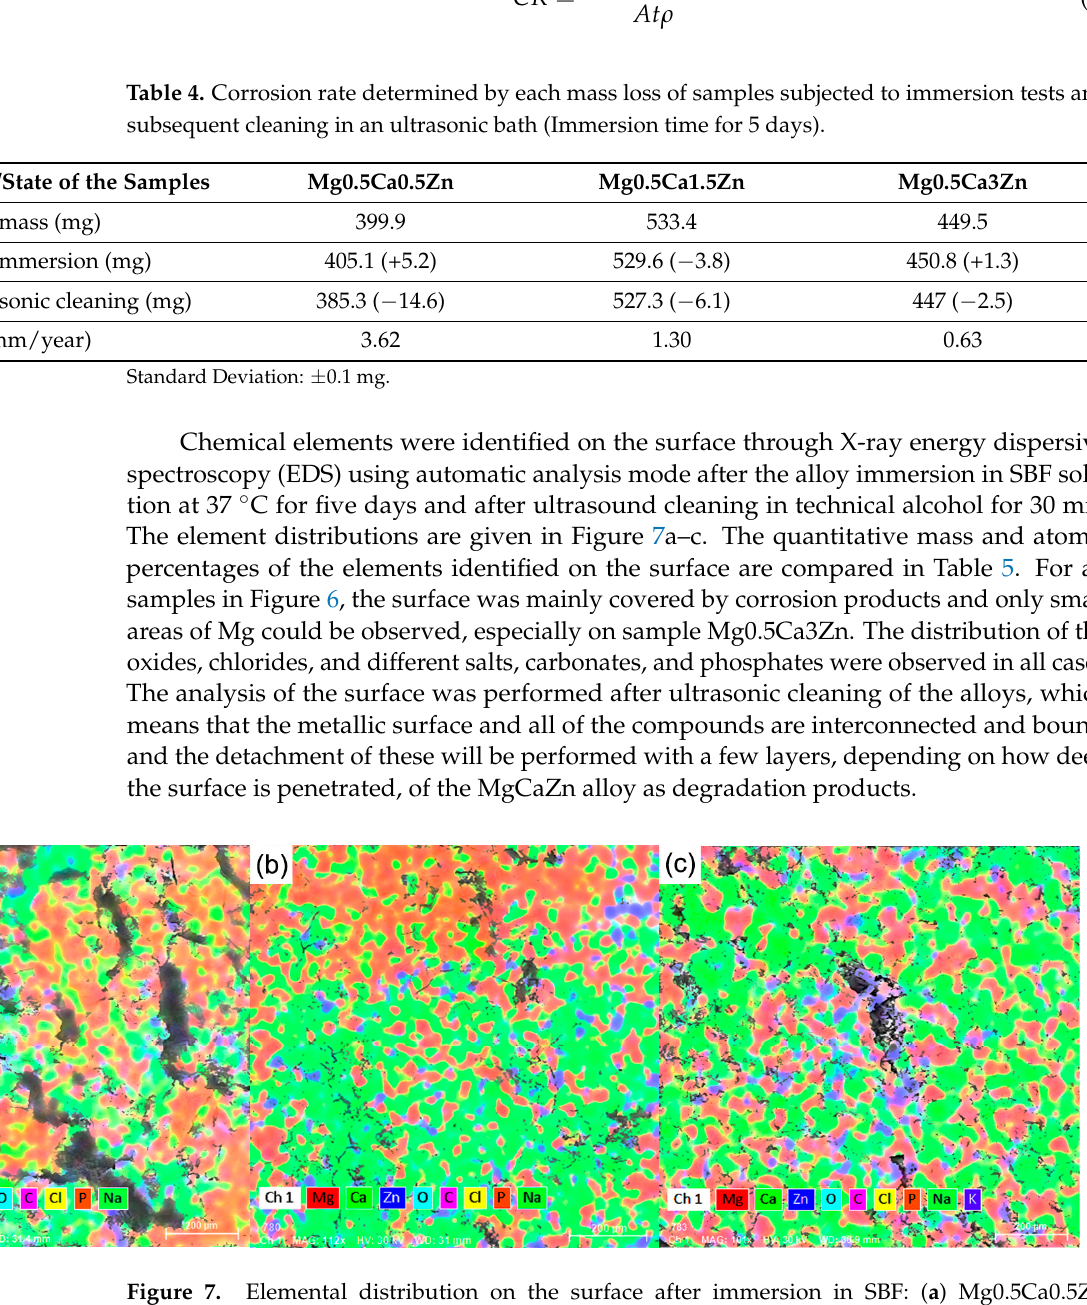
Table 5. Chemical composition of the surface after immersion in SBF and ultrasound cleaning (30 min in technical alcohol, the results represent an average value of three determinations on a 1 mm 2 surface).